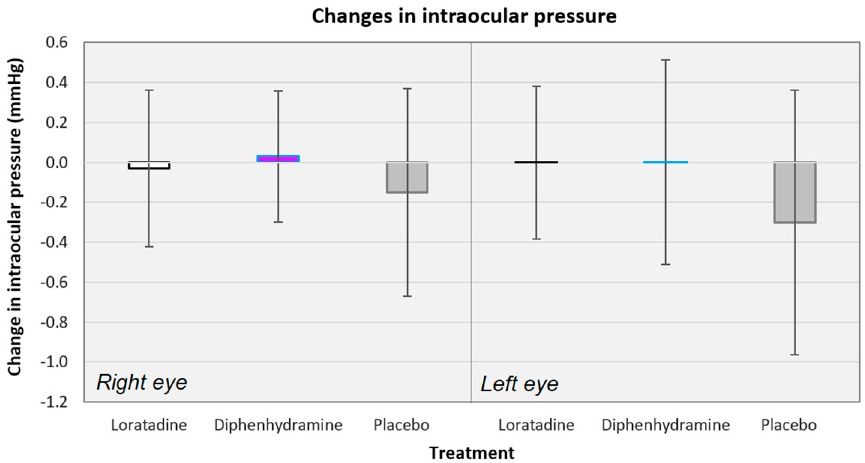
Figure 4. Changes in the intraocular pressure averaged across all subjects for the right and left eyes, separately. There were no significant differences between treatments for either eye. Error bars represent ±95% confidence intervals.